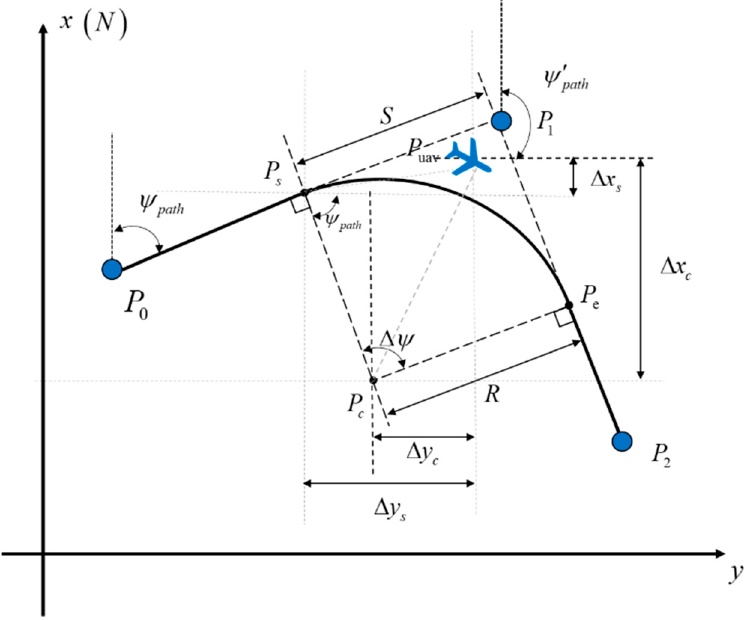
Figure 6. Turn navigation (clockwise turn).